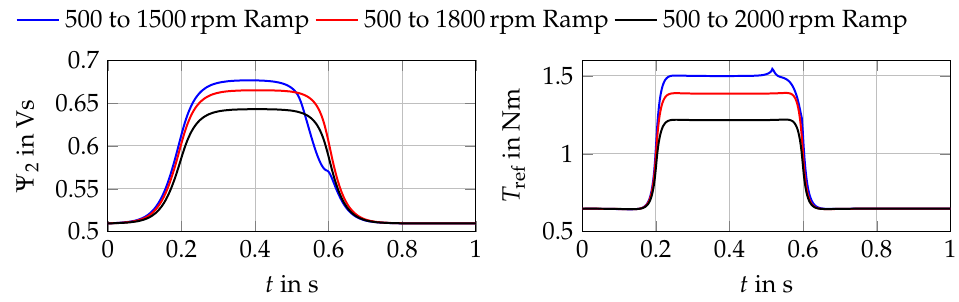
Figure 12. Simulation of optimal flux trajectories and torque for different torque steps for a 370W motor.